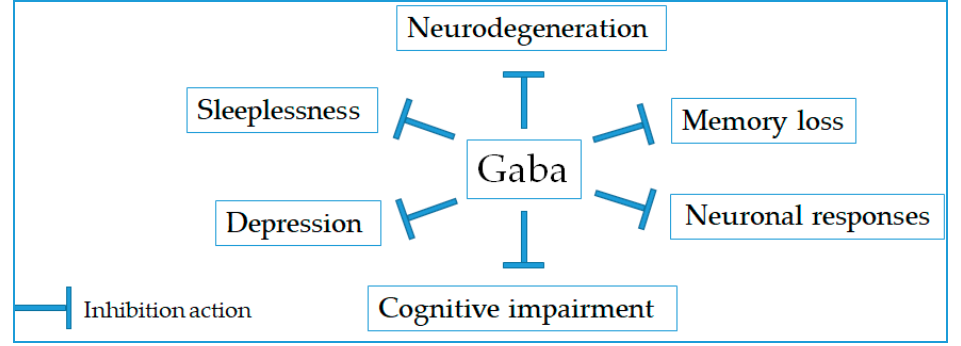
Figure 2. Preventive action of Gaba on neurological disorders. Table 2. Neurological disorder prevention of